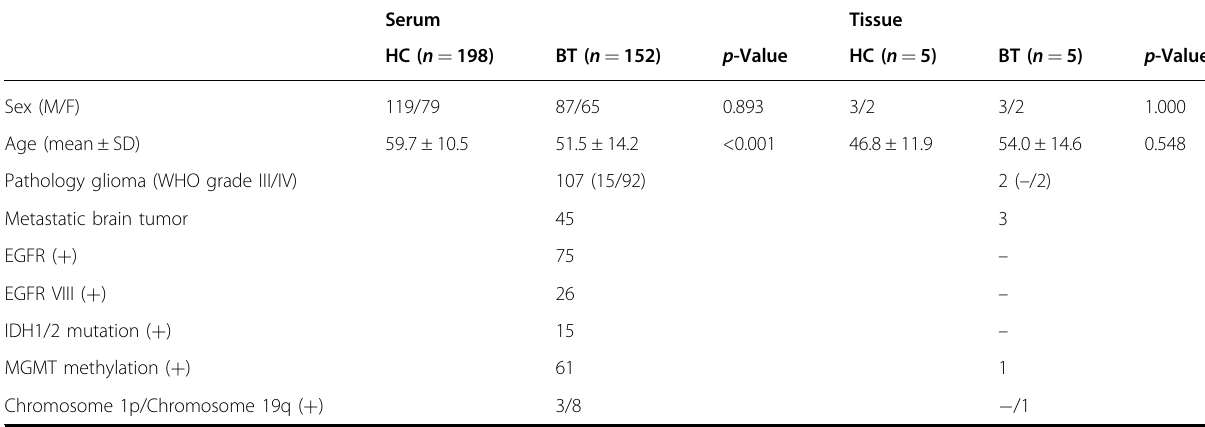
Table 1 Subjects ’ clinical